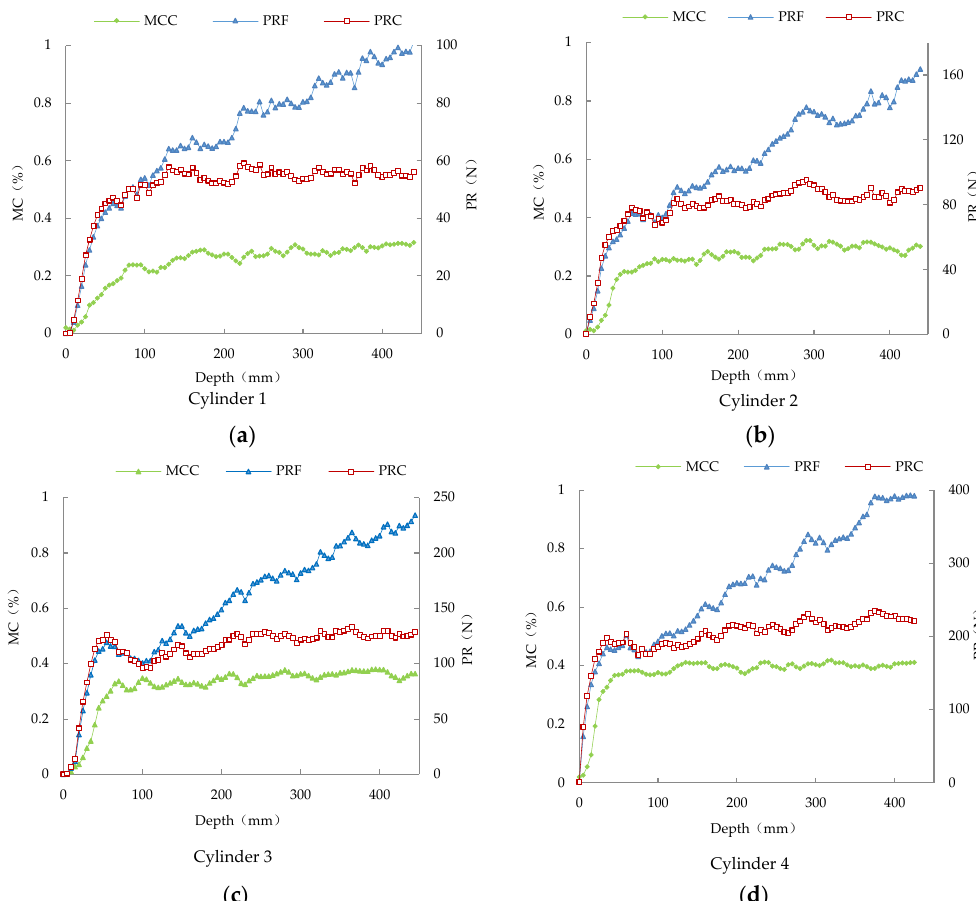
Figure 9. Dynamic measurement results of the compound sensor of Cylinder 1 to Cylinder 4.